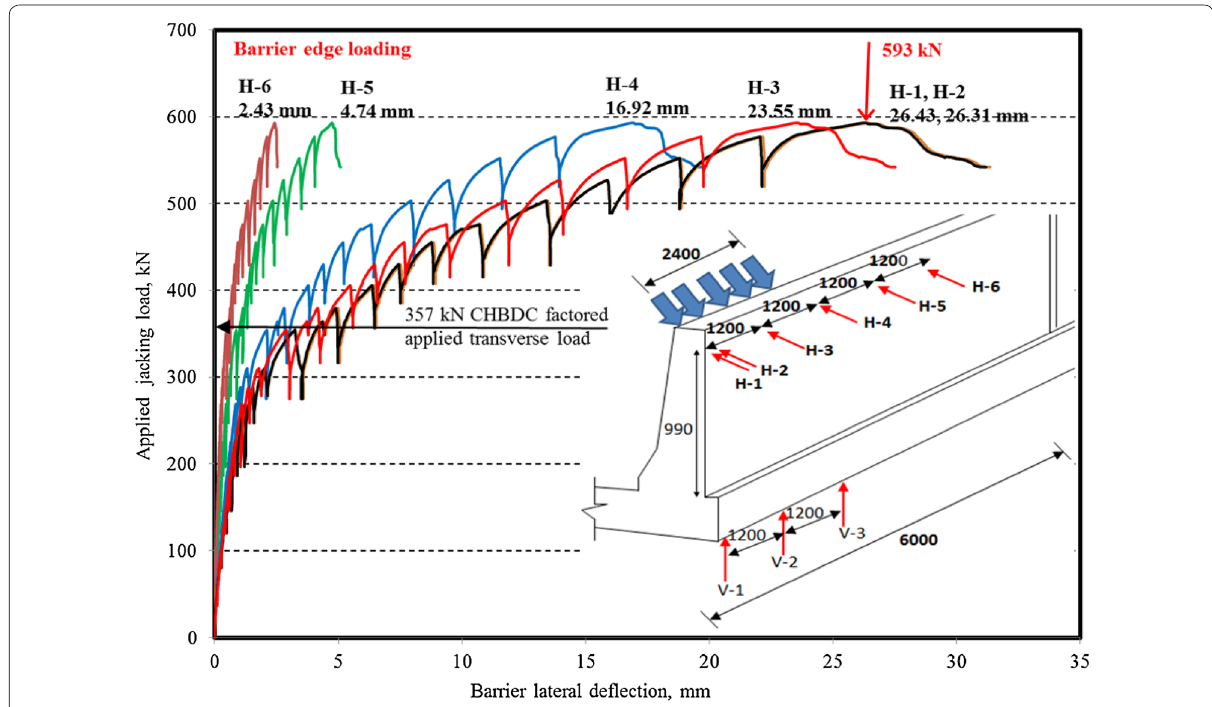
Fig. 7 Load-deflection relationship of the barrier wall loaded at end location.